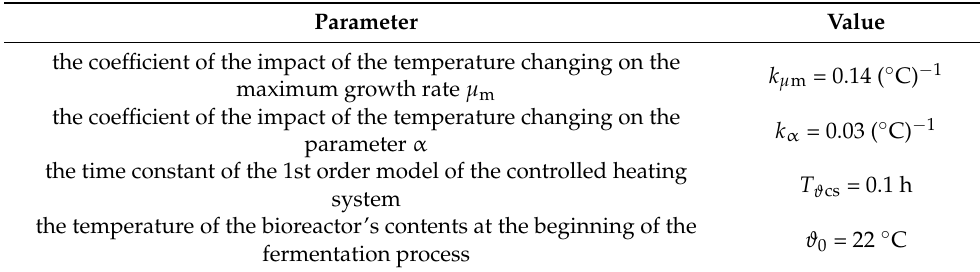
Table 3. Additional parameters of the augmented mathematical model for the fermentation process in the studied bioreactor.